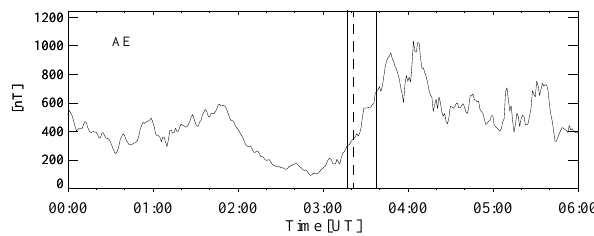
Fig. 1. Provisional AE index from Kyoto for 24 July, 1998. The two vertical lines indicate the time period of PIXIE images, the dashed line gives the time for the substorm onset.